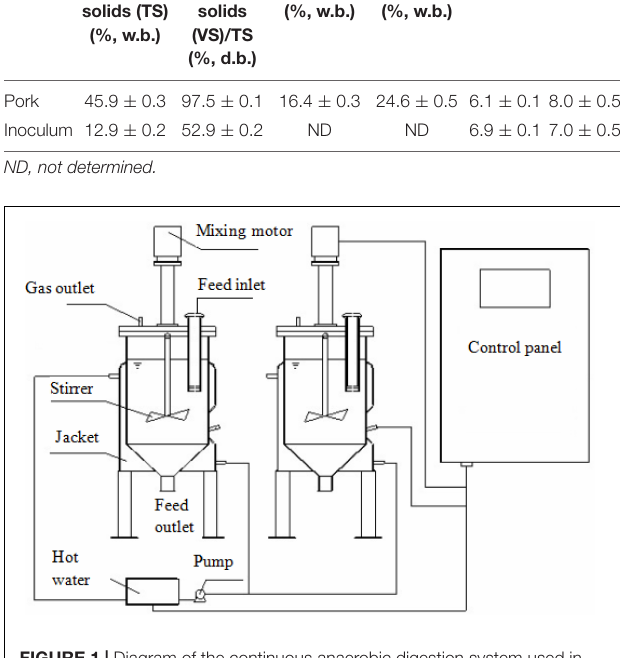
FIGURE 1 | Diagram of the continuous anaerobic digestion system used in the present